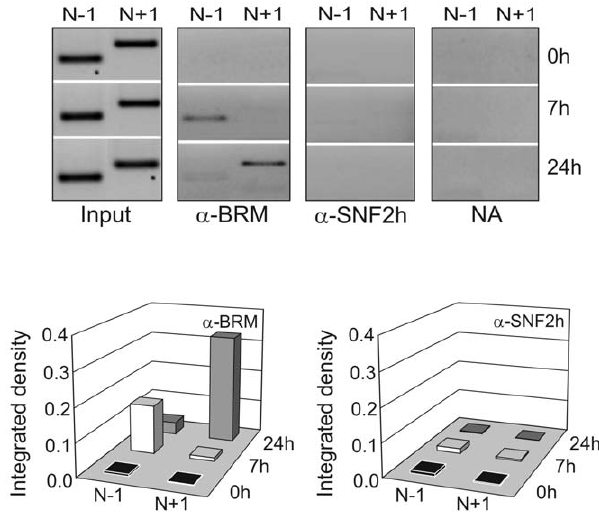
Figure 3. Nuc-ChIP assay of BRM-containing SWI/SNF and SNH2 h-containing ISWI remodeling complexes after PH. The PCR bands were integrated by ImageJ software, the background (no antibody samples, NA) subtracted, normalized by dividing by their corresponding Input samples and represented as histograms at the bottom panel. The images are representative of at least three independent experiments.